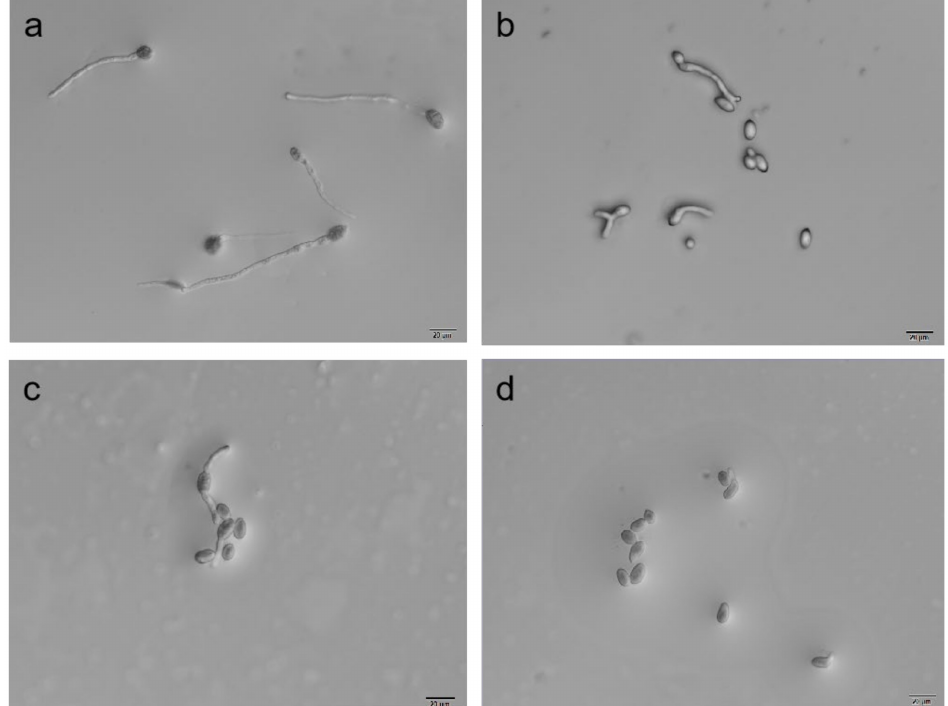
Figure 4. Effects of wuyiencin and ε -PL on conidial germination of Botrytis cinerea under a microscope at 40 × magnification. ( a ): Germination at 36 h after treatment with distilled water. ( b ): Germination at 36 h after treatment with 200 µ g/mL ε -PL. ( c ): Germination at 36 h after treatment with 60 µ g/mL wuyiencin. ( d ): Germination at 36 h after treatment with 200 µ g/mL ε -PL + 60 µ g/mL